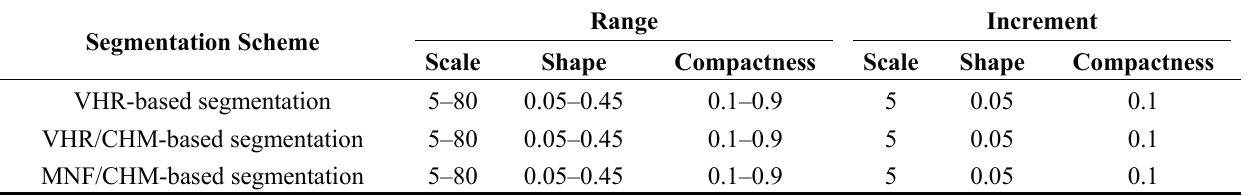
Table 3. Segmentation parameters for each of the integration